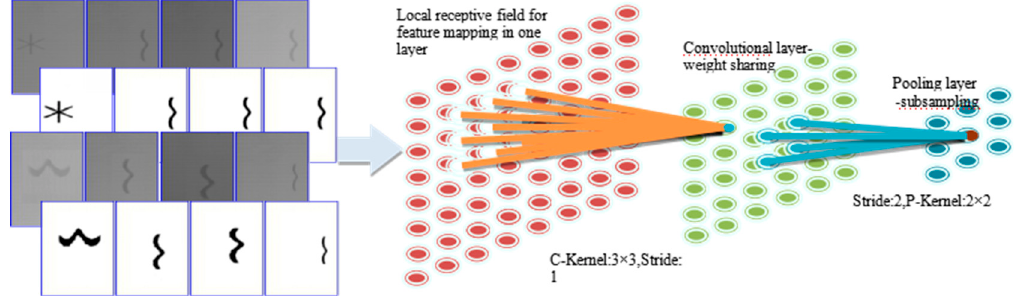
Figure 7. The convolution and pooling process in CNNs for locality perception and parameters sharing mechanism.